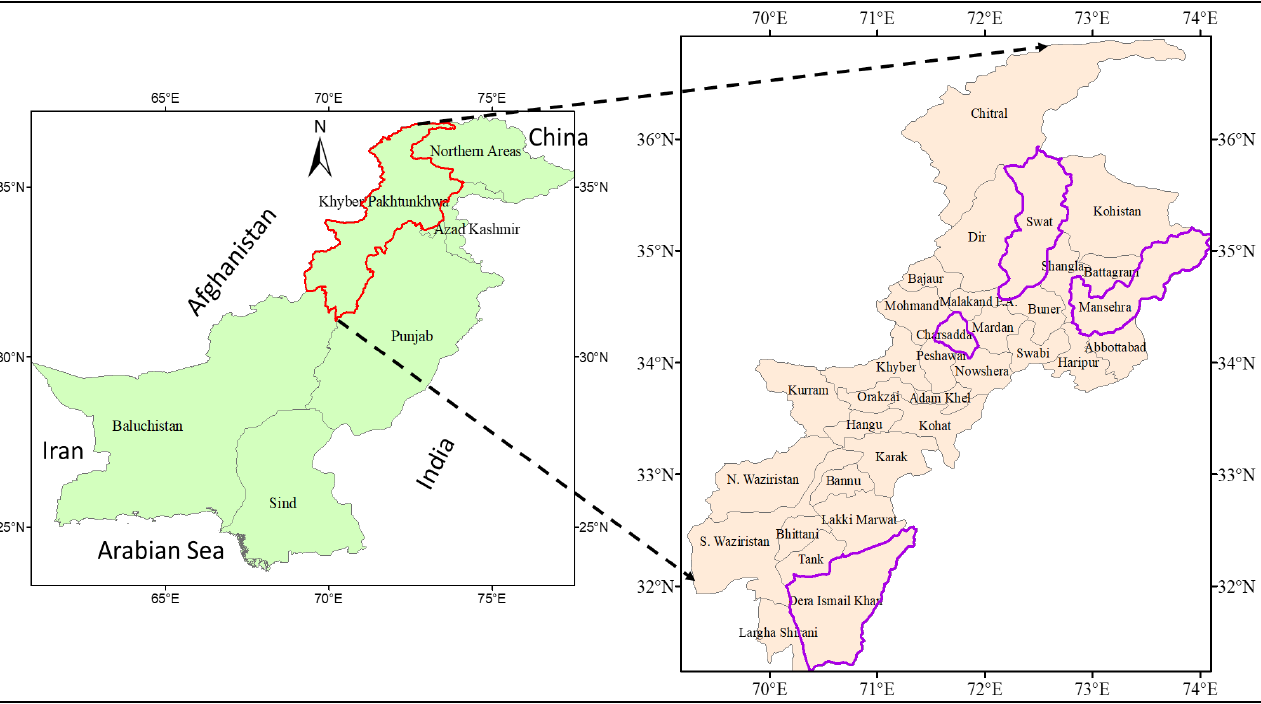
Figure 1. Map of the study area [69]. Table 1. Sample distribution. Table 1. Sample distribution.